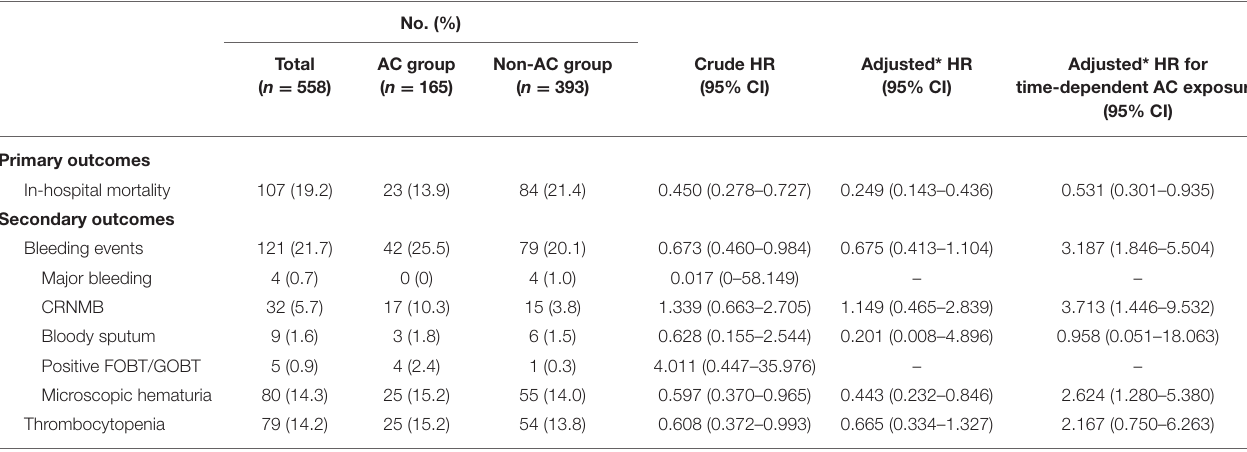
TABLE 2 | Primary and secondary outcomes of PS matched cohort.